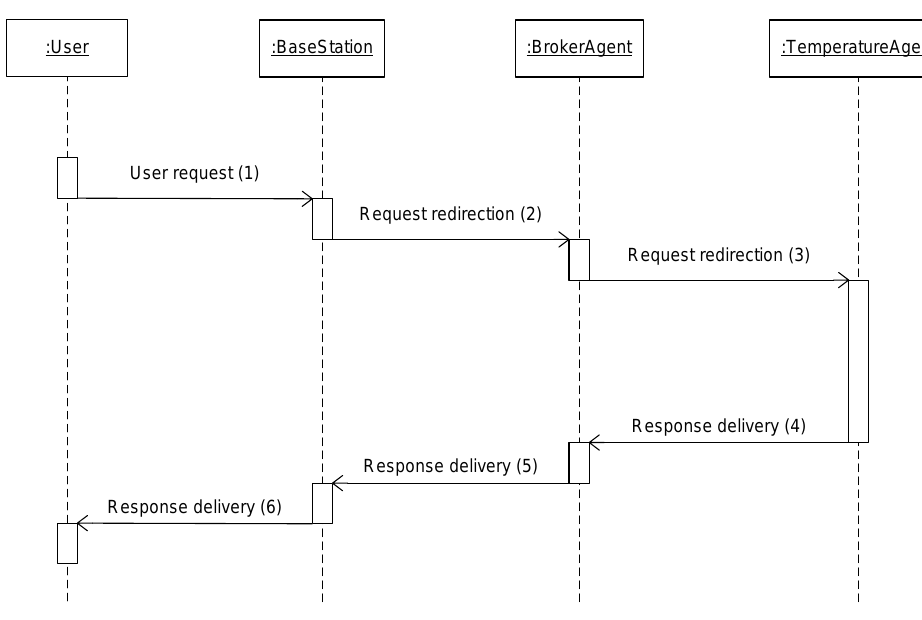
Figure 4. Sequence diagram for a simple service.